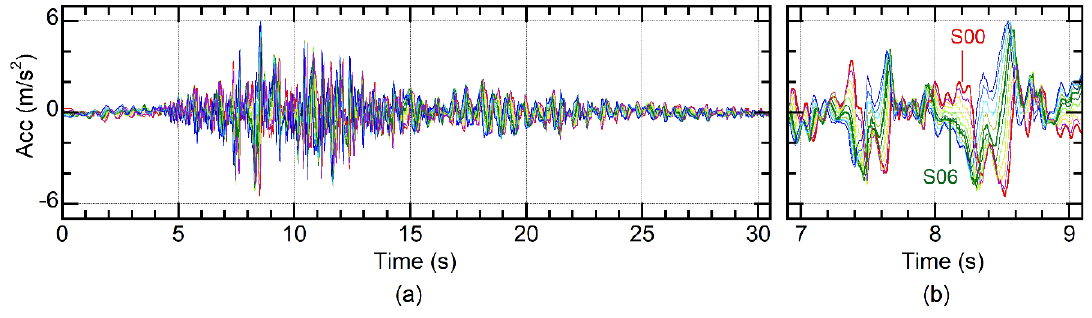
Figure 7. Comparison of the 12 waves of the Art-S series: ( a ) 0 to 30 s and ( b ) 7 to 9 s.